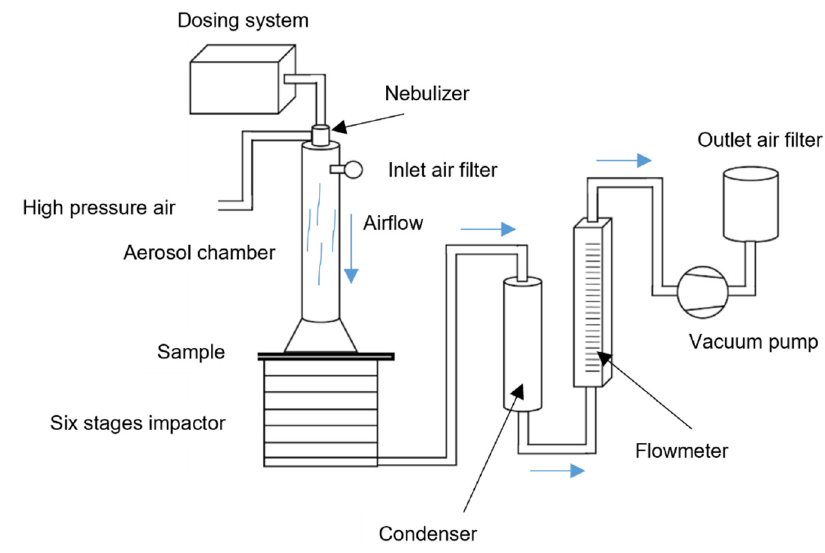
Figure 4. BFE scheme as reported by the EN 14683 standard